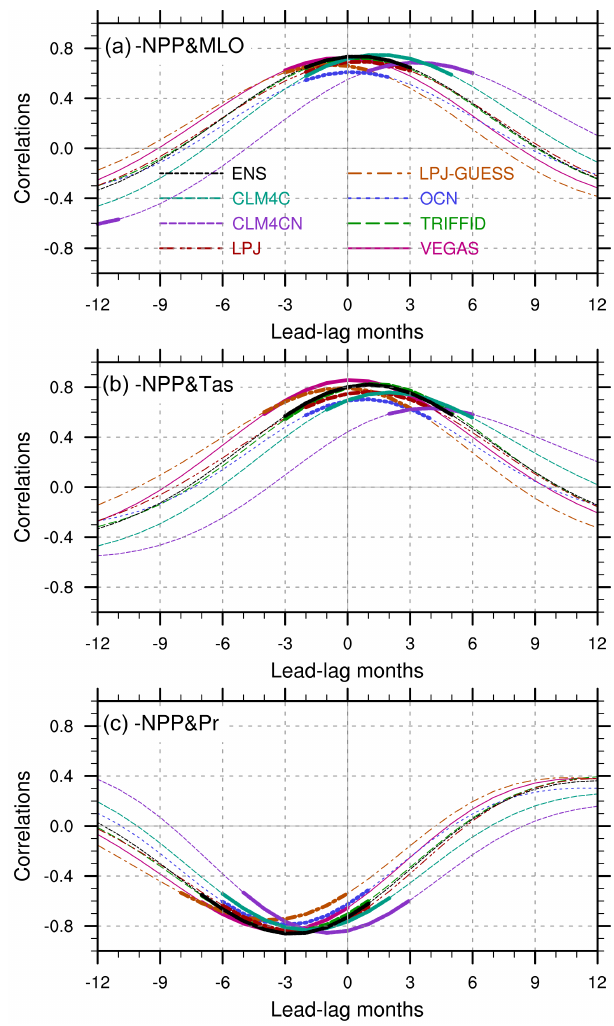
Figure 7. The cross-correlations of − NPP with Mauna Loa CGR, tropical near-surface temperature, and precipitation over land. The negative months on the horizontal axis indicate that the anomalies in − NPP lag behind. Bold lines indicate correlation above 95% significance ( p ≤ 0 . 05).